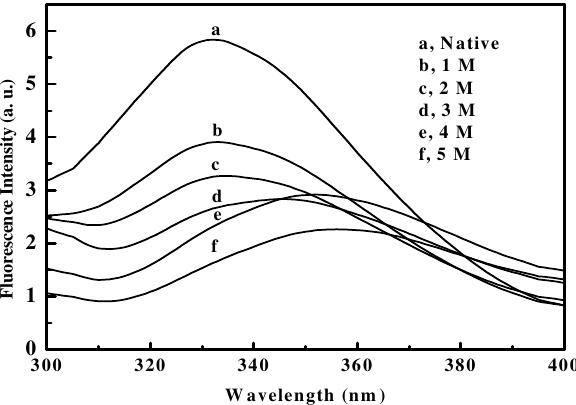
Figure 2. Fluorescence spectra of sLP at varying concentrations of GuHCl.